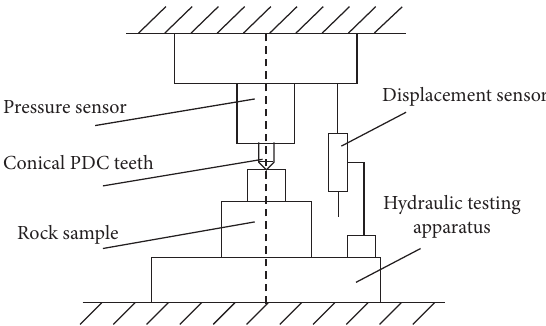
Figure 1: Schematic graph for the static-pressure breaking ex- periment (revised from [14]).